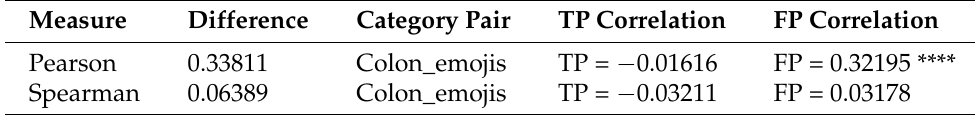
Table 53. Colons and Emojis in Medium.